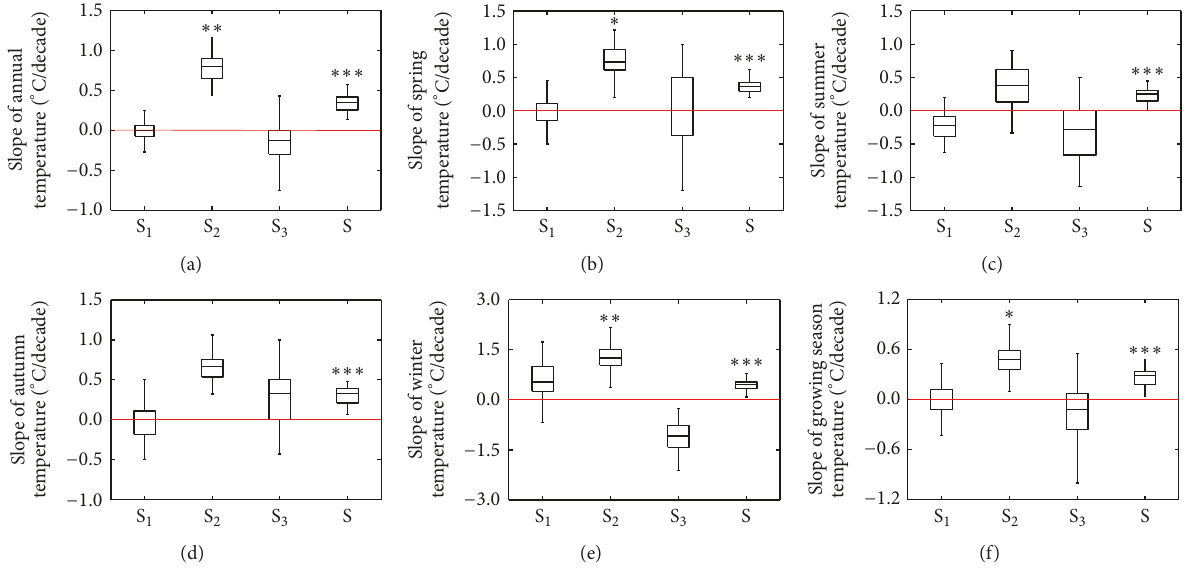
Figure 3: Box-Plot of Slopes for regional average temperature over the BTSSR in different stages. (a) Annual, (b) spring, (c) summer, (d) autumn, (e) winter, and (f) growing season. S 1 is 1960–1978, S 2 is 1979–2000, S 3 is 2000–2014, and S is 1960–2014. ∗ ∗ ∗ is 0.001 level of significance, ∗∗ is 0.01 level of significance, and ∗ is 0.05 level of significance.